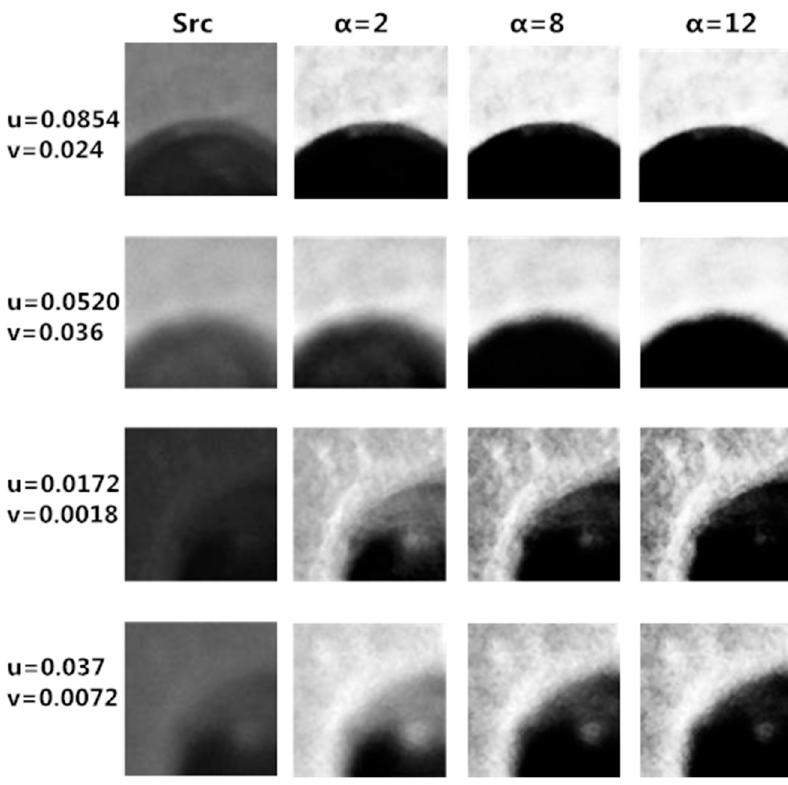
Figure 7. Similarity images of the images with different illuminations.